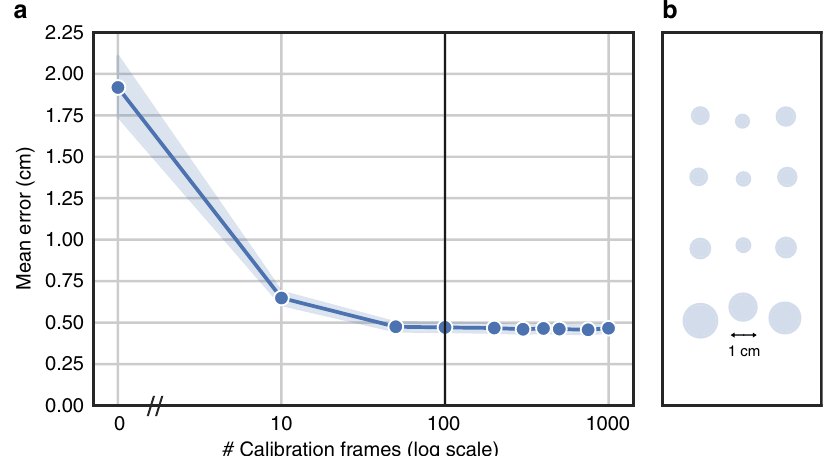
Fig. 1 Accuracy of our smartphone eye tracker. a Gaze estimation accuracy (mean ± s.e.m., n = 26 participants) improves with # calibration frames for personalization. b Error across different screen locations. The radius of the circle indicates average model error at that screen